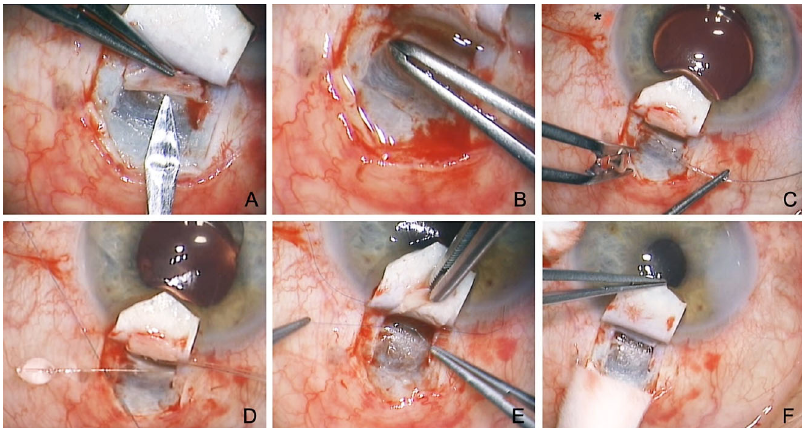
Figure 2. Surgical technique of conventional canaloplasty. ( A ) Unroo fi ng of the SC after the incision of a second deep fl ap into the TDW. ( B ) Peeling of the juxtacanalicular TMW. ( C ) Probing of the SC with a microcatheter (Asterisk marks illuminated tip). ( D ) Insertion of two Prolene 10.0 sutures. ( E ) Kno tt ing of the tension sutures. ( F ) Controlled percolation of aqueous humor through the TDW into the intrascleral cleft.